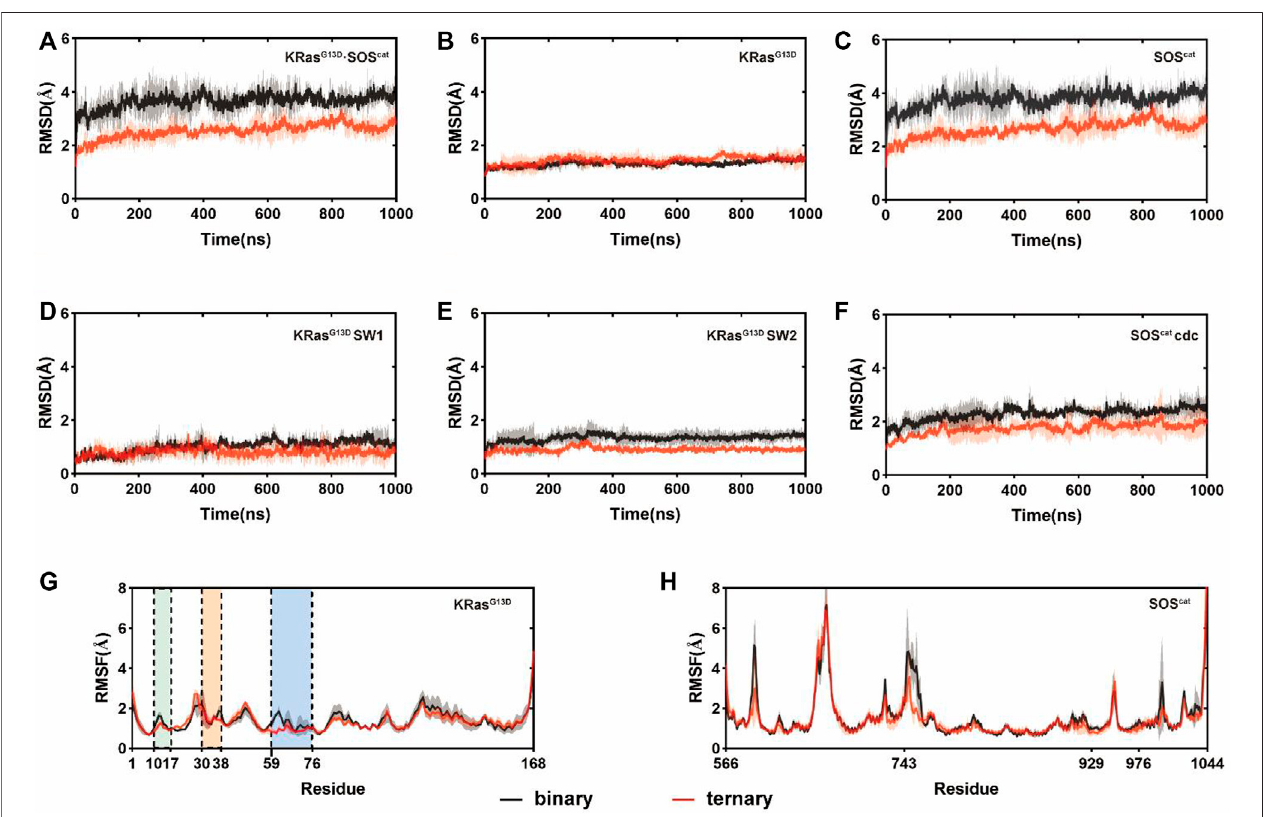
(cid:129) FIGURE1| ConformationaldynamicsoftheK-Ras4B G13D SOS cat complexinthebinaryandternarysystems.RMSDsofC α atomsinthebinary(black)andternary (cid:129) (red) systems within (A) all K-Ras4B G13D SOS cat complex residues; (B) K-Ras4B G13D residues; (C) SOS cat residues; (D) K-Ras4B G13D switch I residues; (E) K-Ras4B G13D switch II residues, and (F) SOS cat Cdc25 domain residues. RMSFs of C α atoms in the binary (black) and ternary (red) systems within (G) K-Ras4B G13D residues and (H) SOS cat residues. The P-loop, the switch I and switch II regions are marked by green, orange, and blue backgrounds, respectively. Gray and red transparencies represent the standard